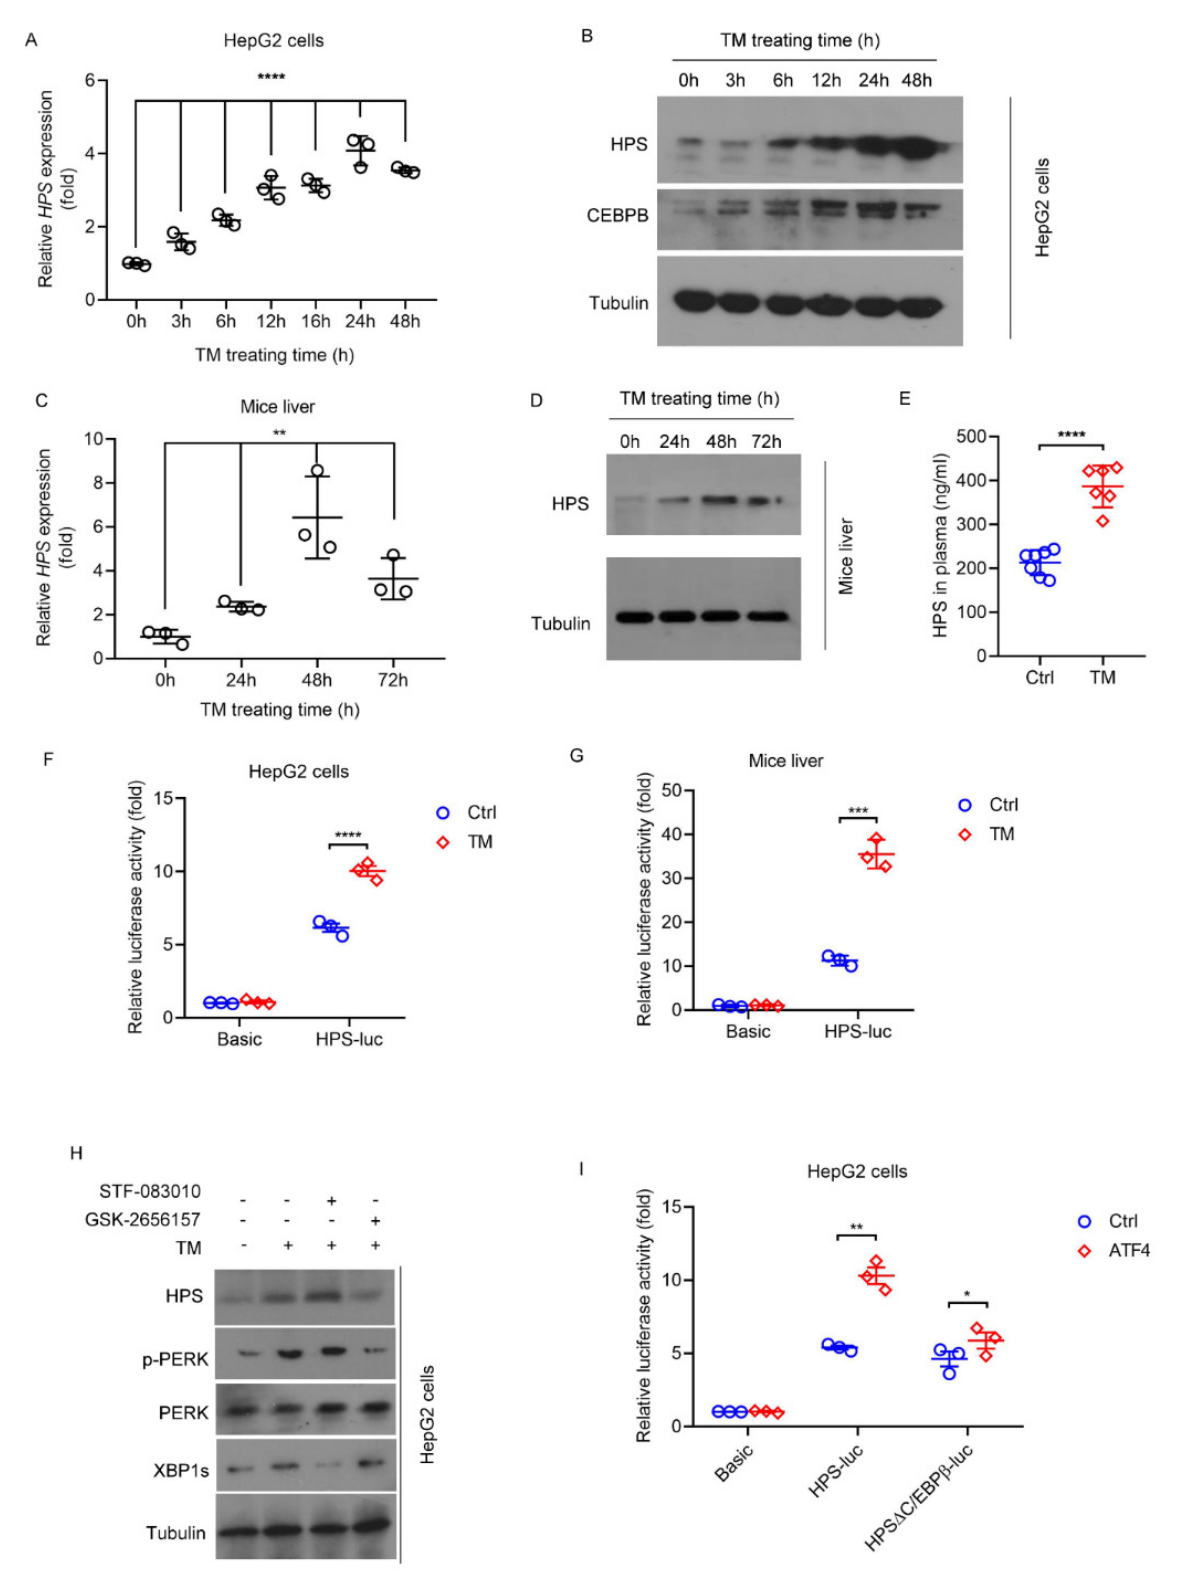
Figure 1. ER stress induces HPS expression in hepatocytes through PERK-ATF4 pathway. For panels ( A , B ), HepG2 cells were treated with TM (4 μ g/mL) for the indicated number of hours. ( A ) Relative expression of HPS mRNA was measured by q-PCR. Two-way ANOVA was used for statistics (F = 59.44, **** p < 0.0001) ( B ) Immunoblotting of protein levels of HPS and CEBPB. For panels ( C – E ), 8- week-old WT C57BL/6J male mice were treated with TM (1 mg/kg body weight) intraperitoneal injection for the indicated number of hours. ( C ) Relative expression of HPS mRNA was measured by q-PCR ( n = 3). Two-way ANOVA was used for statistics (F = 17.82, ** p = 0.0022) ( D ) The liver protein samples of 3 mice in each group were pooled for immunoblotting analysis to detect the levels of HPS. ( E ) ELISA was performed to measure HPS levels in plasma of mice ( n = 6–7). ( F ) HepG2 cells were transfected with HPS promoter construct (HPS-luc) and treated with TM (4 μ g/mL) for 24 h. ( G ) HPS promoter construct (HPS-luc) was transfected into the mouse liver by